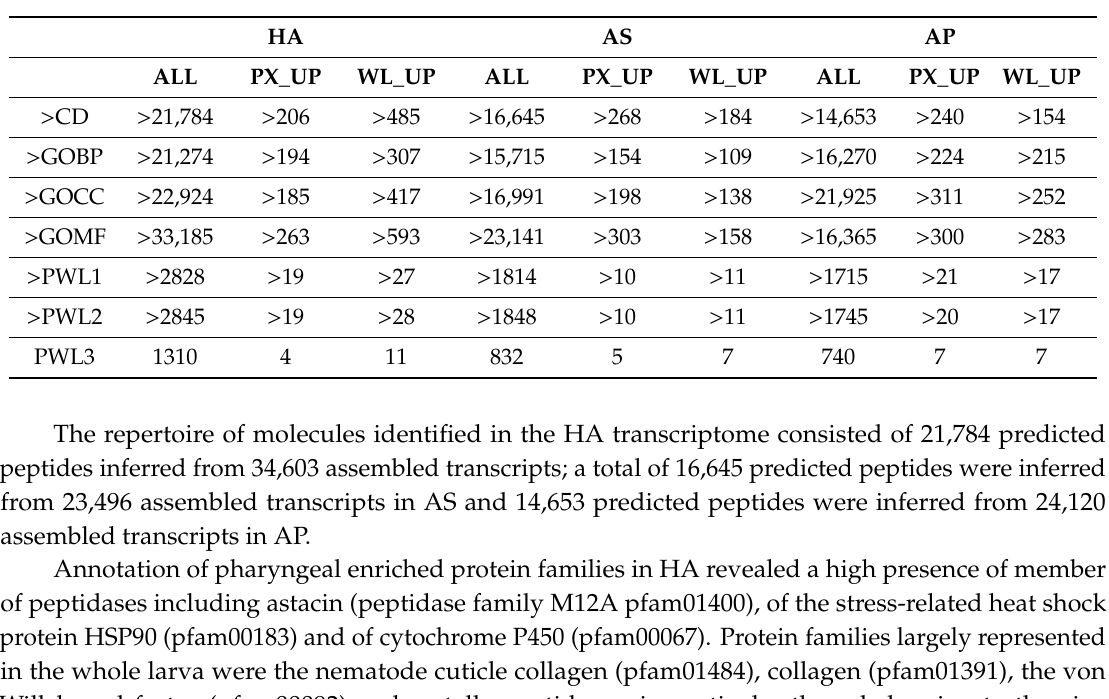
Table 5. Numbers of predicted peptides obtained from the assembled transcripts after annotation analyses with Annocript. (HA: Hysterothylacium aduncum ; AS: Anisakis simplex sensu stricto;